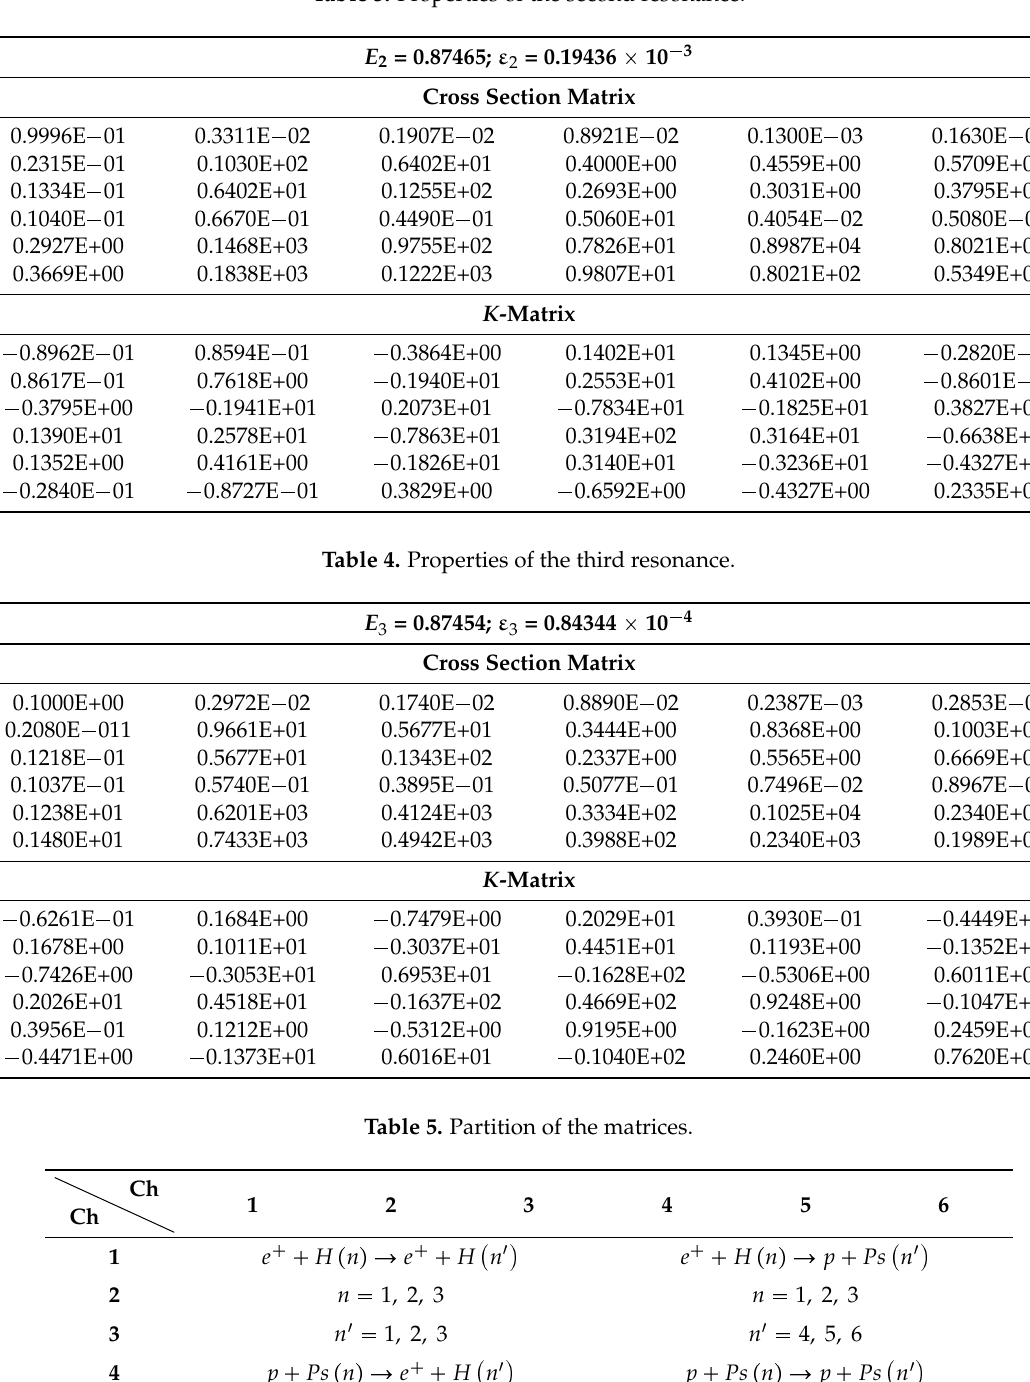
Table 3. Properties of the second resonance.